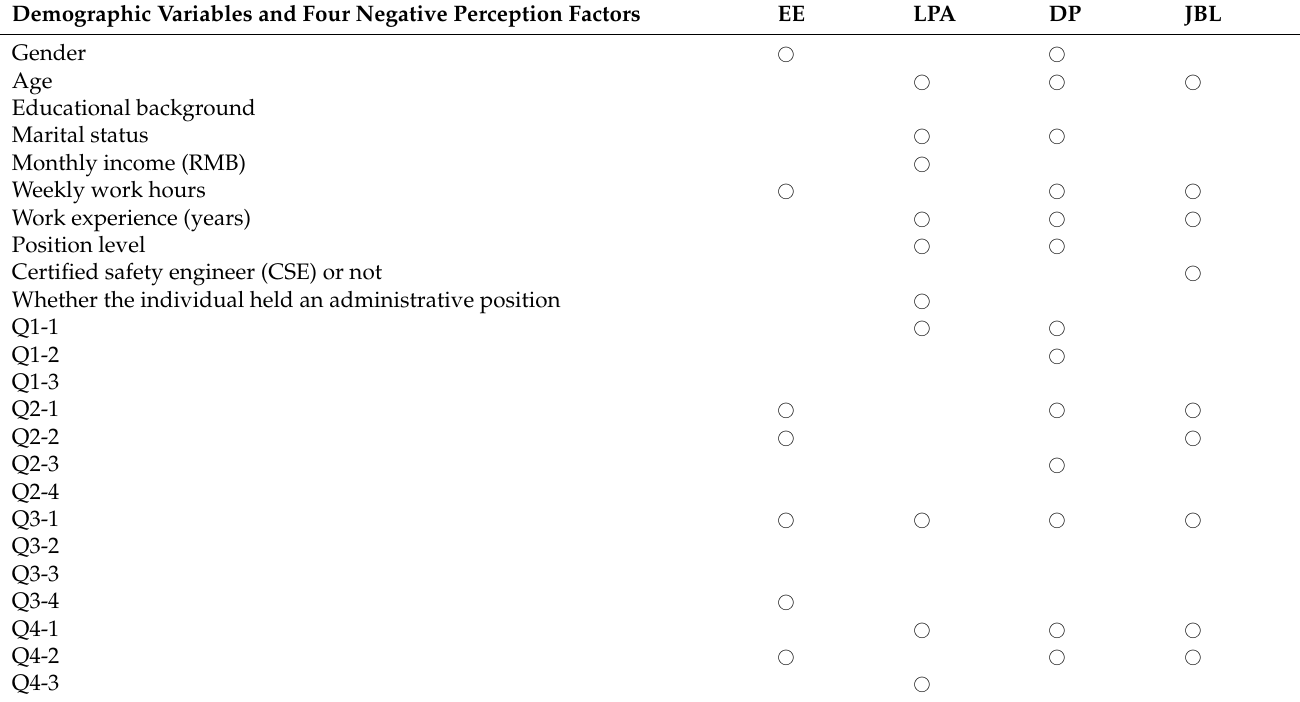
Table 11. Effects of the ten demographic variables and four negative perception factors on job burnout. Demographic Variables and Four Negative Perception